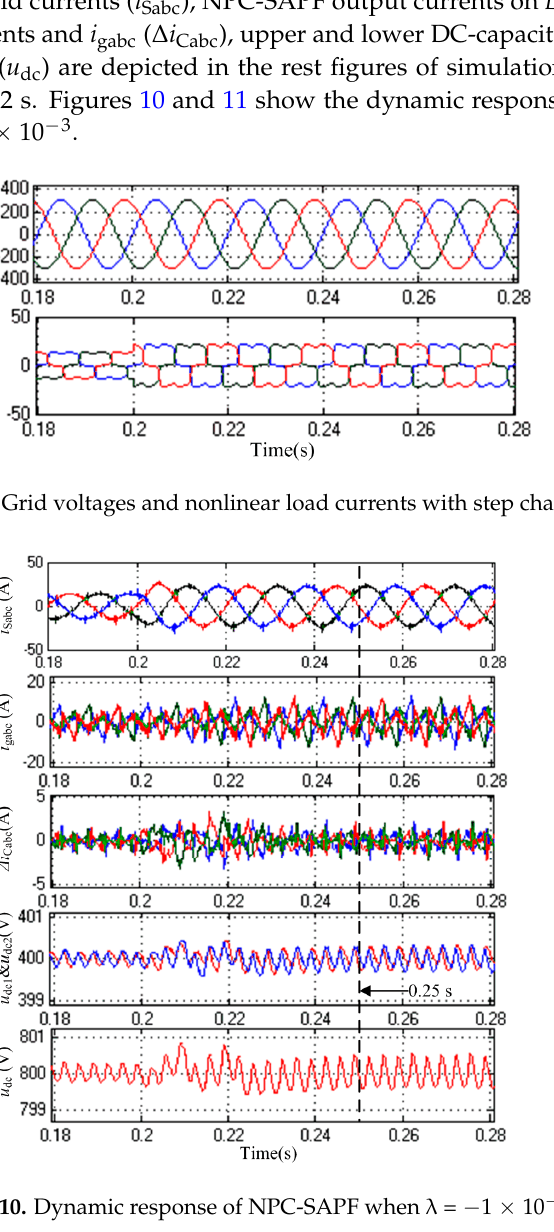
Figure 8. Grid current of phase A and the FFT analysis. ( a ) Grid current waveform by using PR